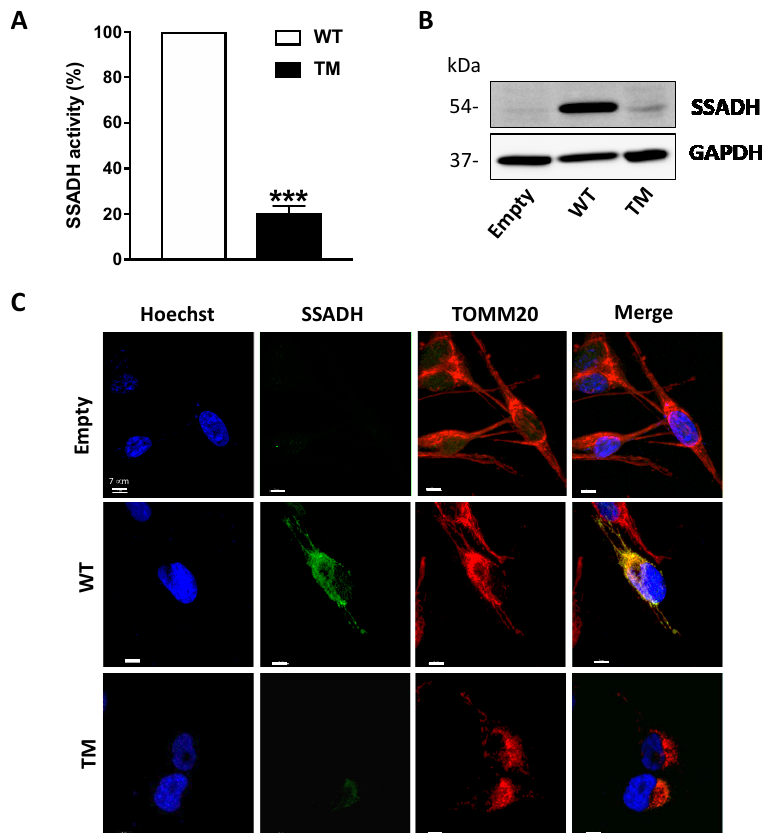
Figure 1. Enzyme activity and protein level of succinate semialdehyde dehydrogenase (SSADH) in U87 cells transfected with wild type (WT) and triple mutant (TM) constructs. U87 cells were transiently transfected for 24 h. ( A ) SSADH enzyme activity was assessed fluorimetrically. WT activity was considered as 100%. Data are expressed as mean ± SD of three separate assays from two separate transfections. *** p < 0.001, Student’s t -test. ( B ) Representative Western blot analysis of SSADH protein levels. Glyceraldehyde 3 phosphate dehydrogenase (GAPDH) was used as loading control. A total of 20 µg of total protein extract was loaded on each lane. ( C ) Confocal microscopy analyses of U87 cells immunostained for SSADH (green) and for the mitochondrial marker TOMM20 (red). Hoechst staining (blue) was used to label nuclei. Scale bar: 7 µm.